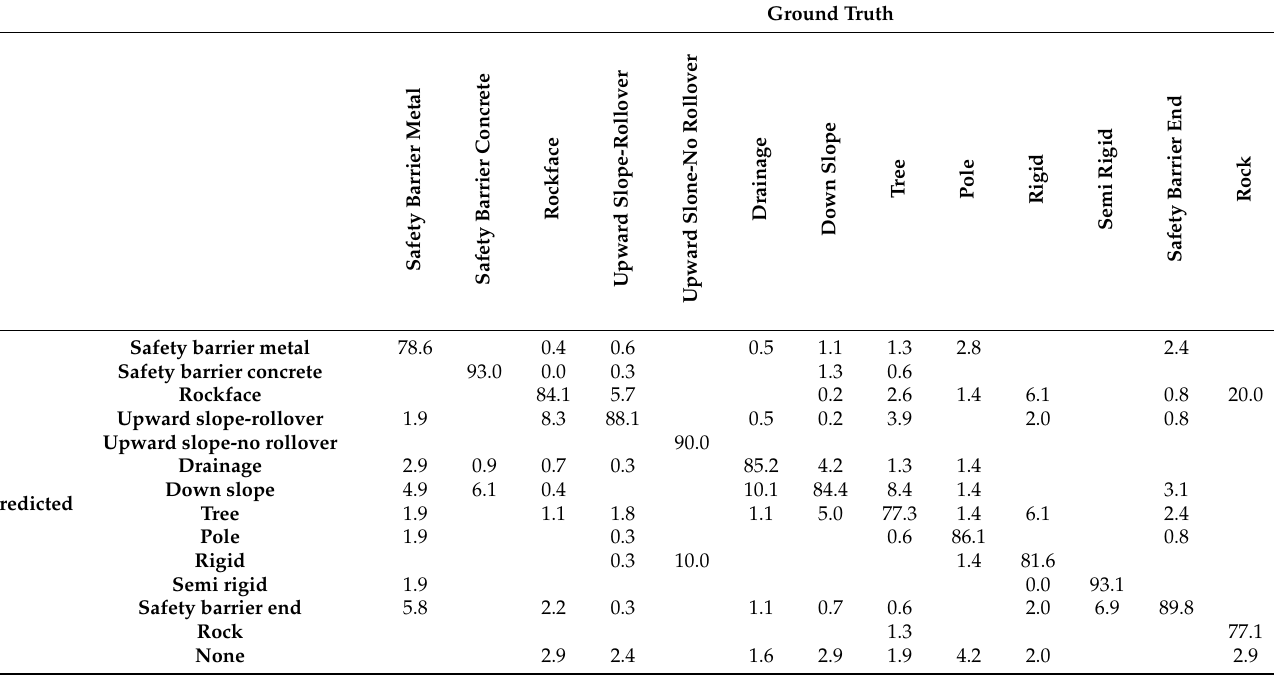
Table 5. Confusion matrix for final road segments classification into one of RSS–O classes presented with